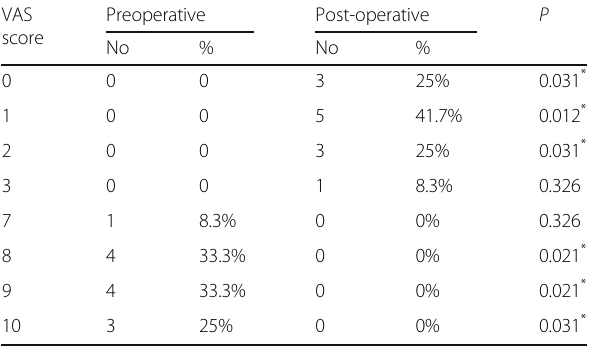
Table 1 VAS score preoperative and post-operative in cases of the